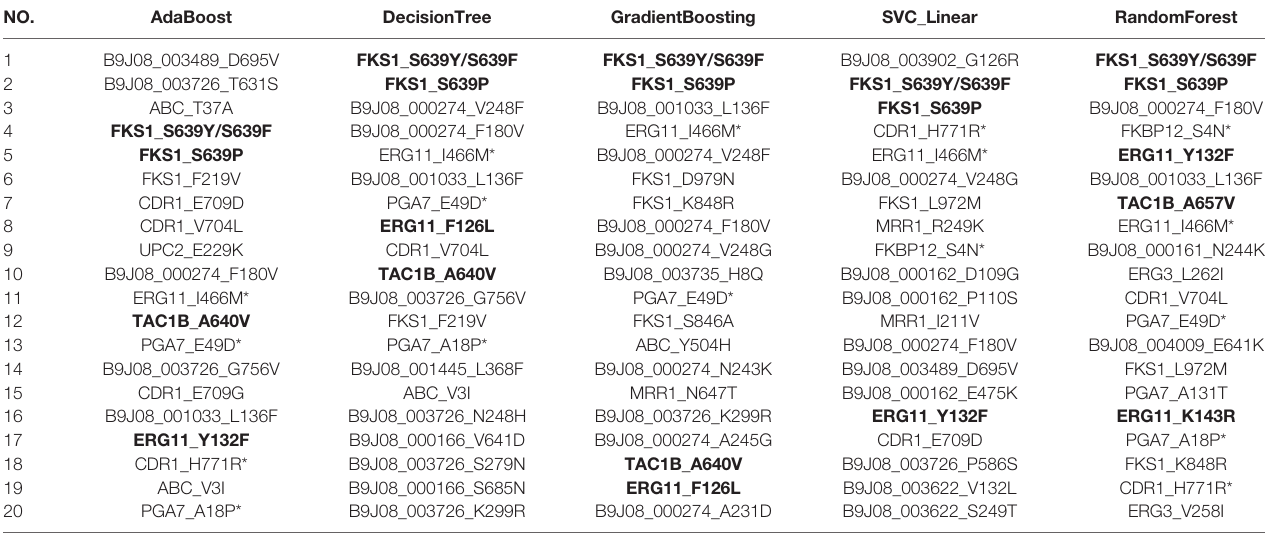
TABLE 5 | Top 20 mutations ranked by RFECV for MCF on F1 set.